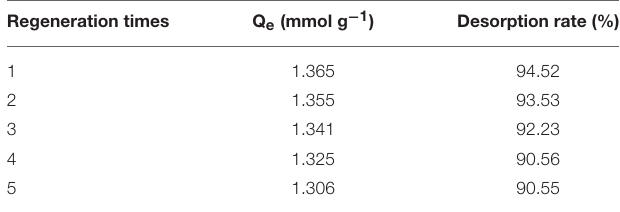
TABLE 6 | Regeneration properties of PPTA-AM-70 for Hg(II) adsorption. Regeneration